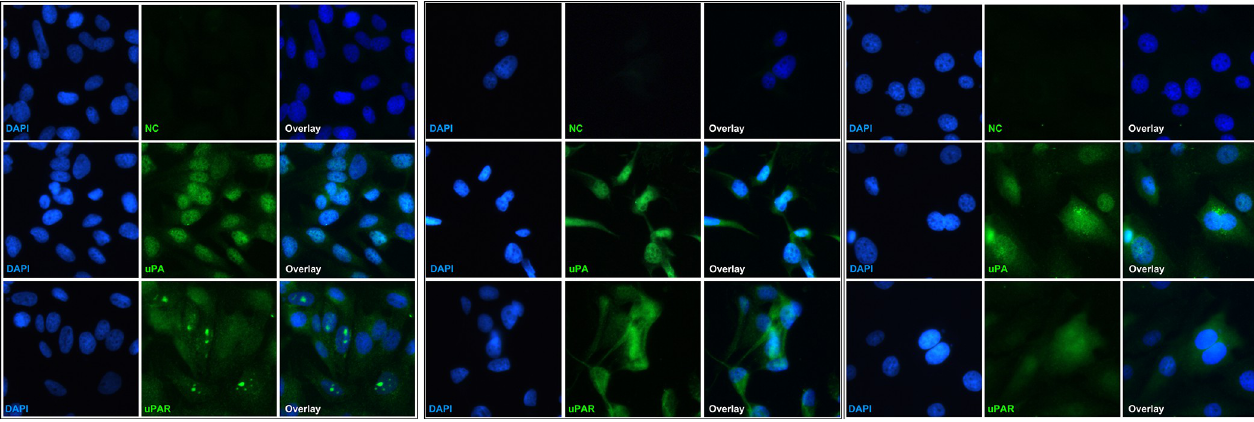
Fig 5. Immunofluorescence images of uPA and uPAR expression in osteosarcoma cell lines. Both diffuse cytoplasmic and nuclear uPA and uPAR positivity are seen in one human osteosarcoma cell line (A) and two canine cell lines D17 (B) and Dharma (C). Nuclear expression was strong in uPA and weak to moderate in uPAR in all three cell lines. Nuclei were stained with DAPI (blue). Primary antibody was omitted in negative control (NC). Images taken at 400x.